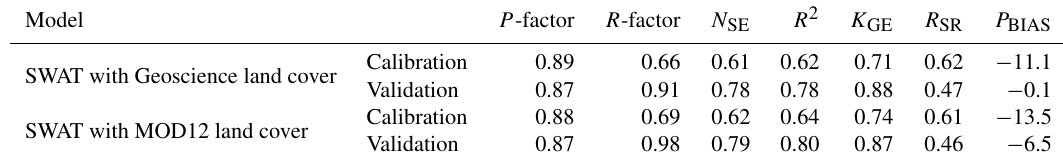
Table 4. Streamflow calibration and validation